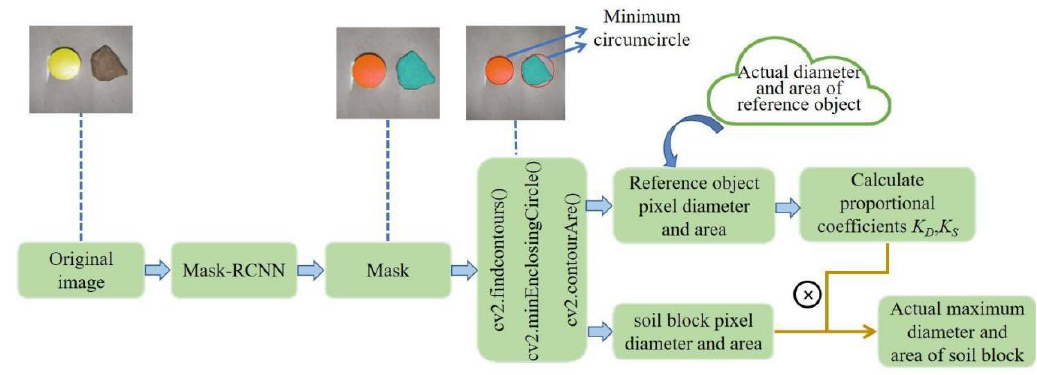
Figure 5. Extraction process of soil block size. Table 2. MWD of different soil block sizes obtained by standard mechanical